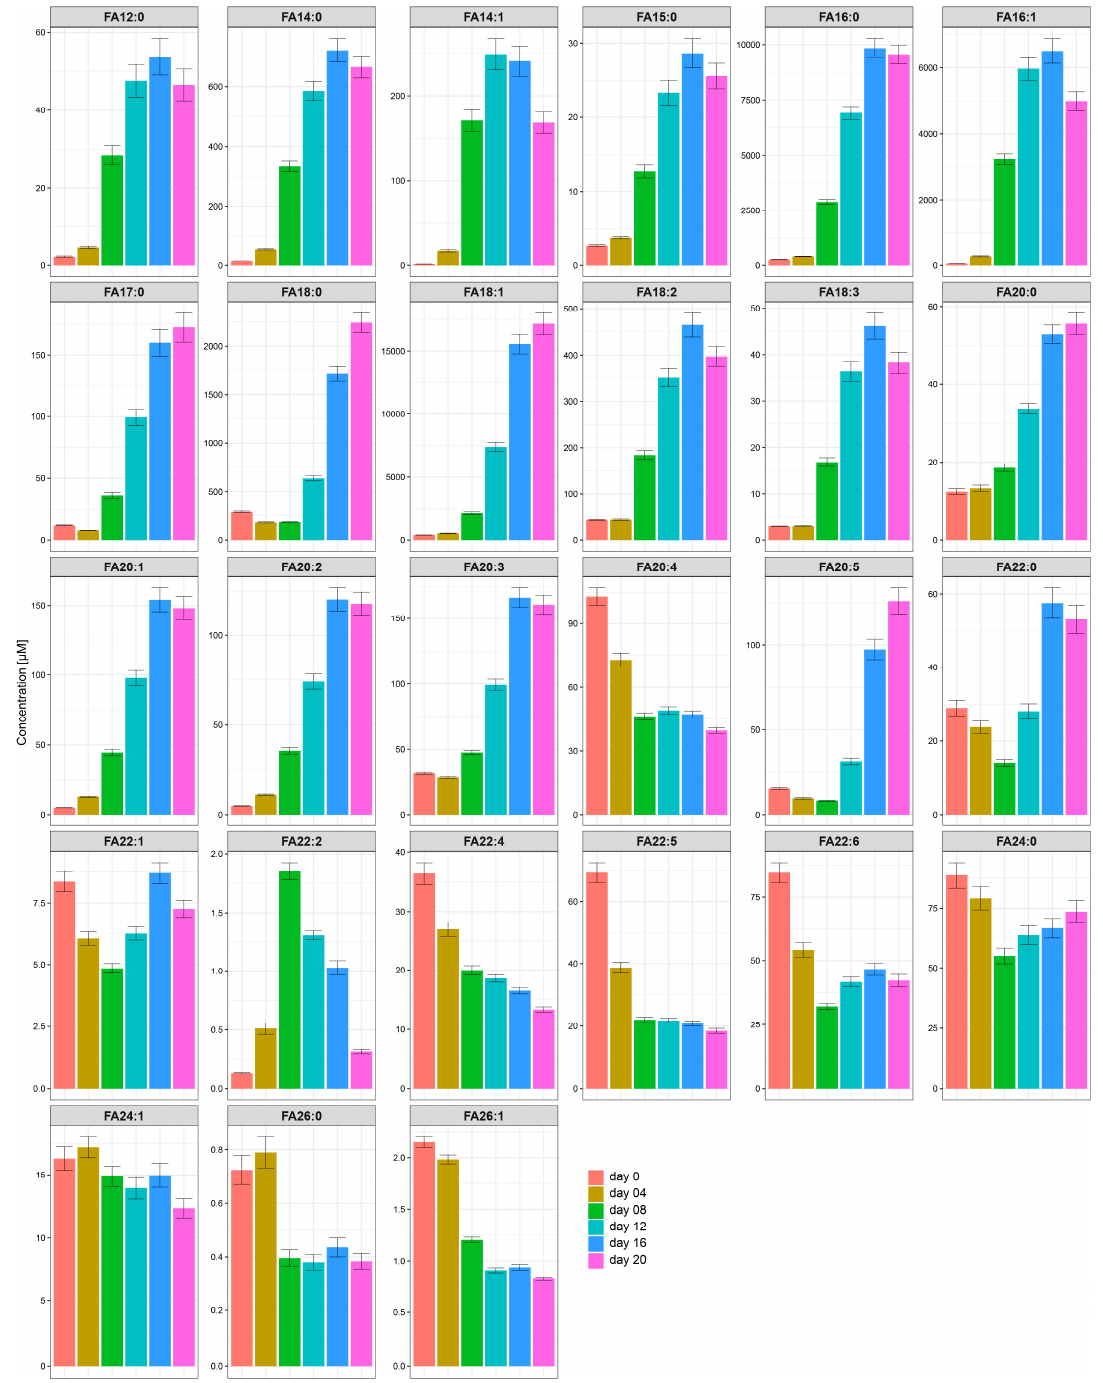
Figure 3. Time courses for the concentrations of the single FA side chains bound in the lipids summarized over all classes. Analysis of summarized lipids’ side chain concentrations over all classes revealed four dominant fatty acids, namely FA 18:1, FA 16:0, FA 16:1, and FA 18:0. Their concentrations increased strongly during adipogenesis together with the other LCFA (with the exception of FA 20:4) and the MCFA 12:0. In contrast, the very VLCFA mostly decreased during